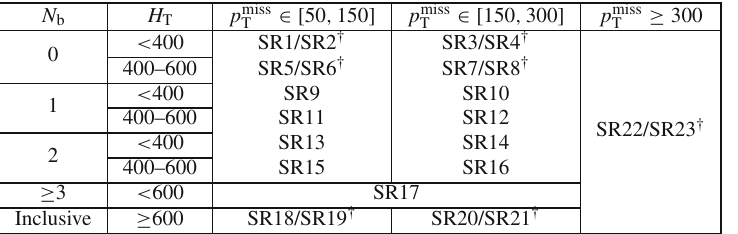
Table 6 The SR definitions for the on-ZML category. All SRs in these categories require N jets ≥ 2. Regions marked with † are split